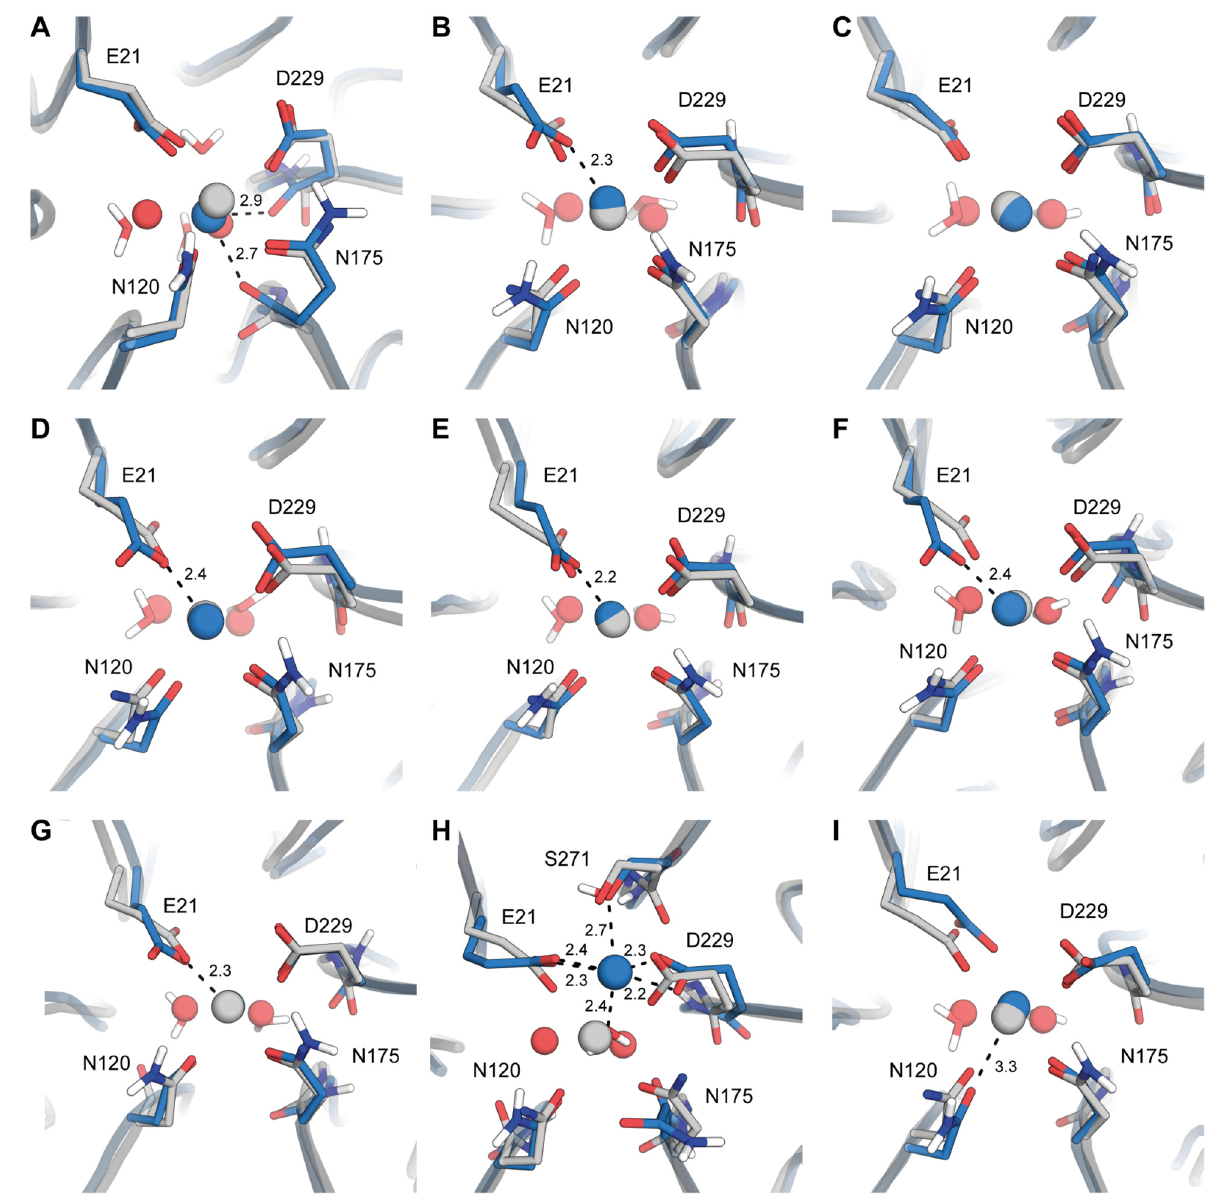
Figure 2. Structural disturbances in catalytic Ca 2+ site of DFPase when modeled with different parameter combinations. ( A ) State a showcased on Amber19sb-DEF results. ( B ) State b , Amber19sb-DUM. ( C ) State c , Amber19sb-COM. ( D ) State d , CHARMM36m-DEF. ( E ) State e , CHARMM36m-DUM. ( F ) State f , CHARMM36m-COM. ( G ) State g , OPLS-AA/M-DEF. ( H ) State h , OPLS-AA/M-DEF. ( I ) State i , OPLS-AA/M-DUM. Modeled systems are shown in blue, shown in gray are coordinates from PDB ID 3O4P. Non-polar hydrogen atoms and outer dummy atoms in DUM models are omitted for clarity.